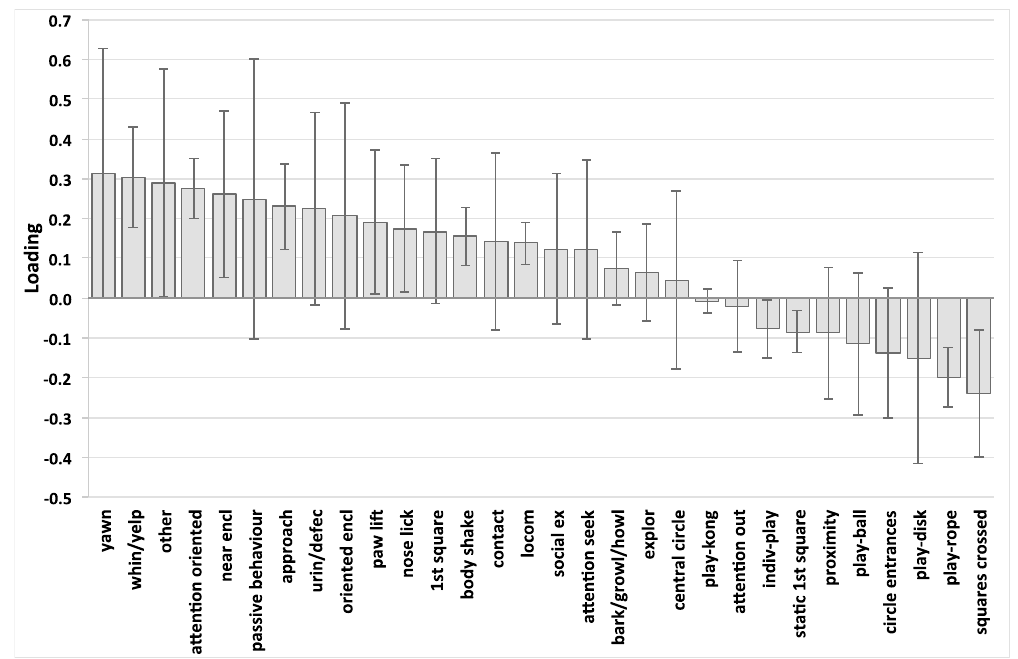
Figure 1. Loadings bar chart of projection to latent structures analysis (PLS) of arena test variables versus maternal care principal components analysis (PCA) score. Positive loadings (upward pointing bars) indicate the puppy behaviours that are positively associated with maternal care score, and negative loadings (downward pointing bars) indicate the puppy behaviours that are negatively associated with maternal care score. Height of bars is an index of the strength of that association. However, the chart should be viewed and interpreted as a pattern. Whiskers indicate 95% confidence interval. Legend: yawn (Yawning), whin/yelp (Whining/Yelping), other (Other behaviours), attention oriented (Attention oriented to the stranger), near encl. (Near the enclosure), passive behaviour (Passive behaviour), approach (Approach), urin/defec (Urination and/or defecation), orientated encl (Behaviours orientated to the enclosure), paw lift (Paw lifting), nose lick (Nose licking), 1st square (Puppy in the 1st square), body shake (Body shaking), contact (Physical contact with the stranger), locom (Locomotion), social ex (Social exploration), attention seek (Attention seeking), bark/growl/howl (Barking, Growling, Howling), explor (Exploration), central circle (Puppy in the central circle), play-kong (Individual play-Kong), attention out (Attention oriented outdoor the enclosure), indiv-play (Individual play), static 1st square (Static in the 1st square), proximity (Proximity), play-ball (Individual play-ball), circle entrances (Number of entrances in the central circle), play-disk (Individual play-plastic disk), play-rope (Individual play-rope), squares crossed (Number of squares crossed).